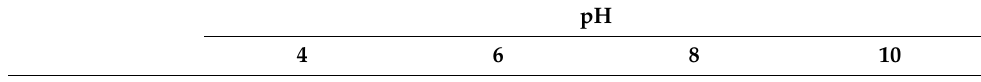
Table 3. CFD analysis result.